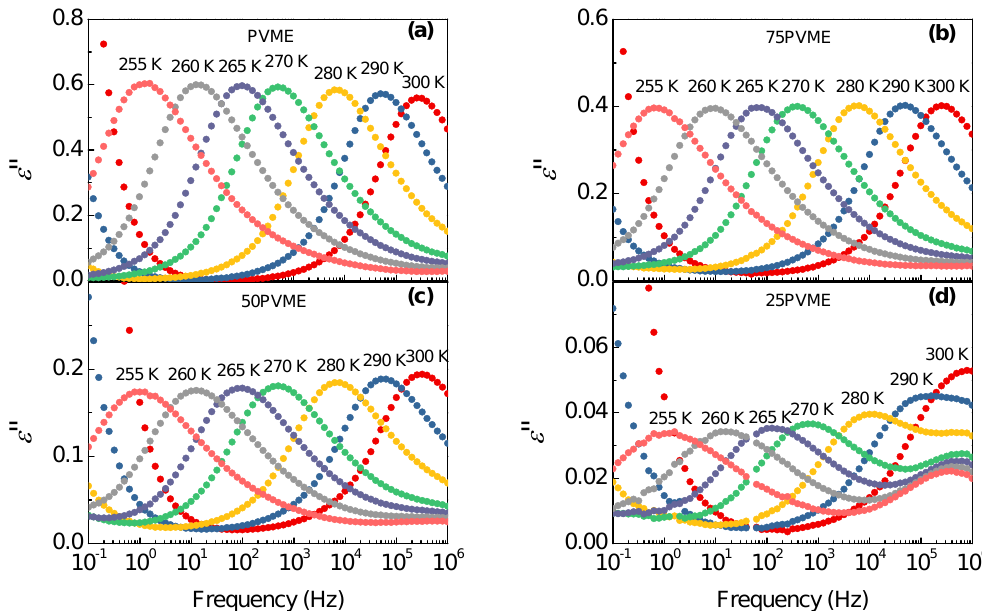
Figure 5. Dielectric loss curves at several temperatures above T g for ( a ) pure PVME and PVME/SCNP mixtures with various compositions: ( b ) φ PVME = 75%, ( c ) 50%, and ( d ) 25%.